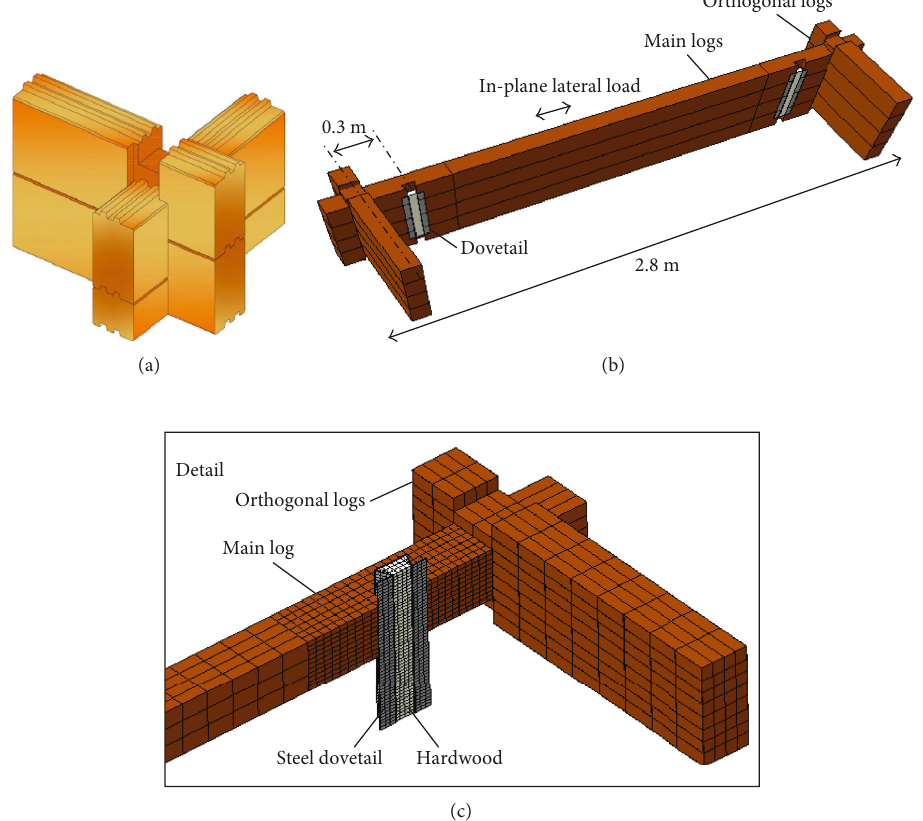
Figure 8: FE numerical modelling of log-wall assembly with steel dovetails. (a) Example of “Standard” carpentry joint and (b) overview of a typical FE model, with (c) evidence of mesh pattern, corner detail